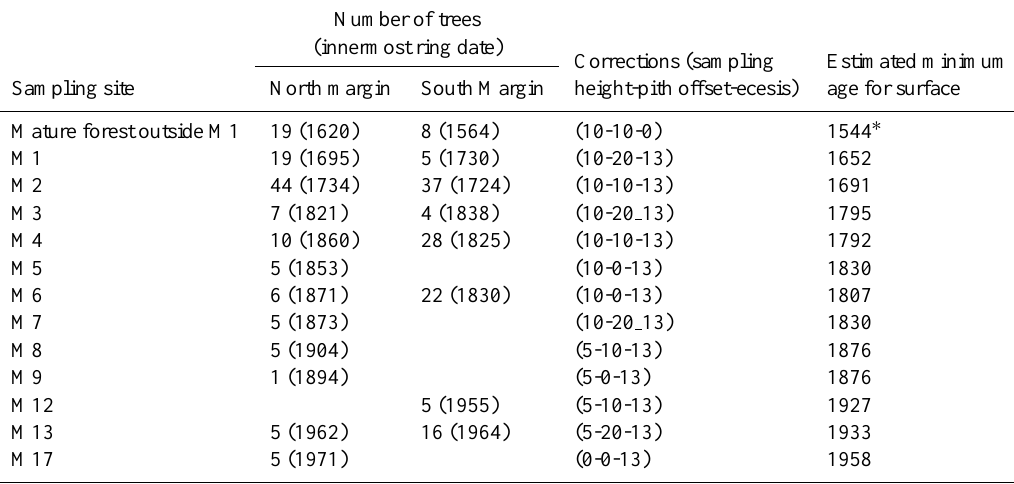
Table 1. Dendrochronological dating of moraines at Glaciar Esperanza Norte. The number of trees and earliest ring date from the oldest tree sampled at each surface are indicated. Minimum ages were estimated after accounting for pith offset, sampling height, and a constant 13-yr ecesis correction. Minimum ages of moraines are derived from Nothofagus pumilio (lenga) except M9 that was dated using a sample from Fitzroya cupressoides